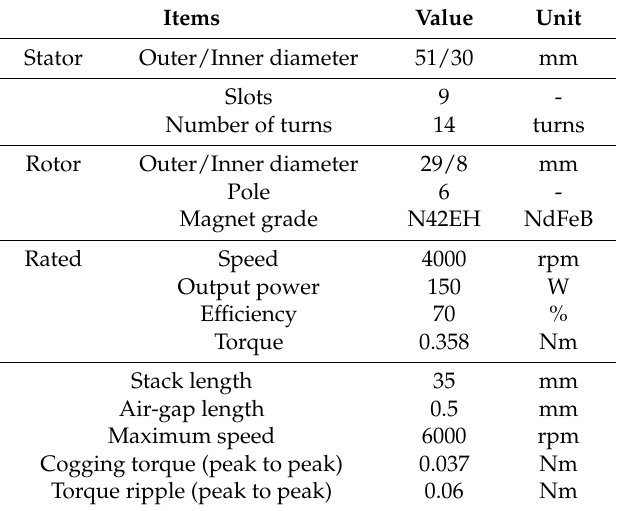
Table 1. Specifications of the conventional BLDC motor.